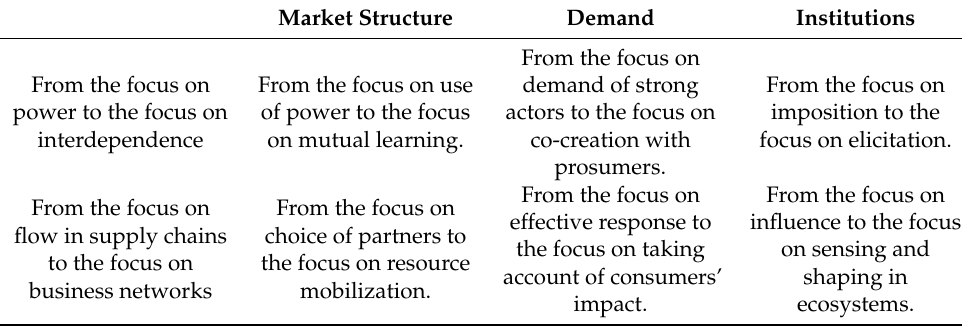
Table 2. Framework for innovation research in the food sector from the perspective of market conditions and power/flow in supply chain. Market Structure